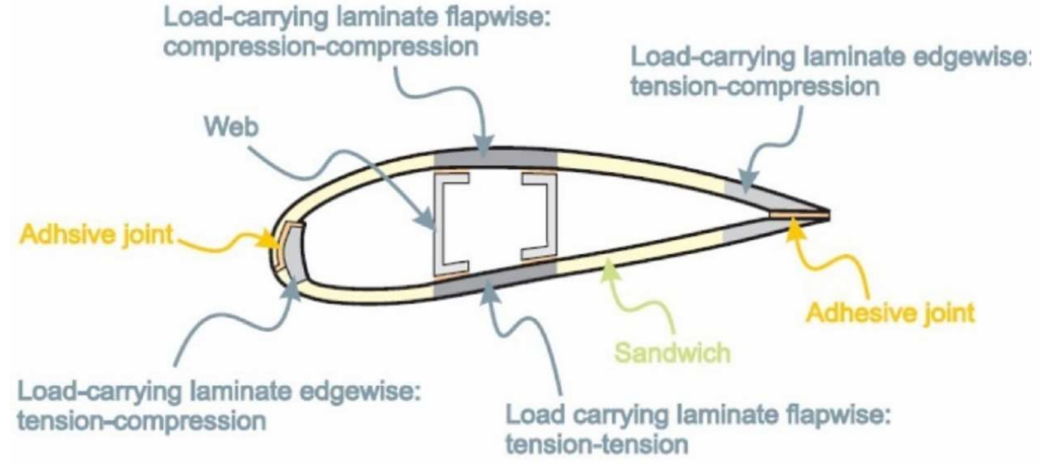
Figure 16. Sectional view of a wind turbine blade